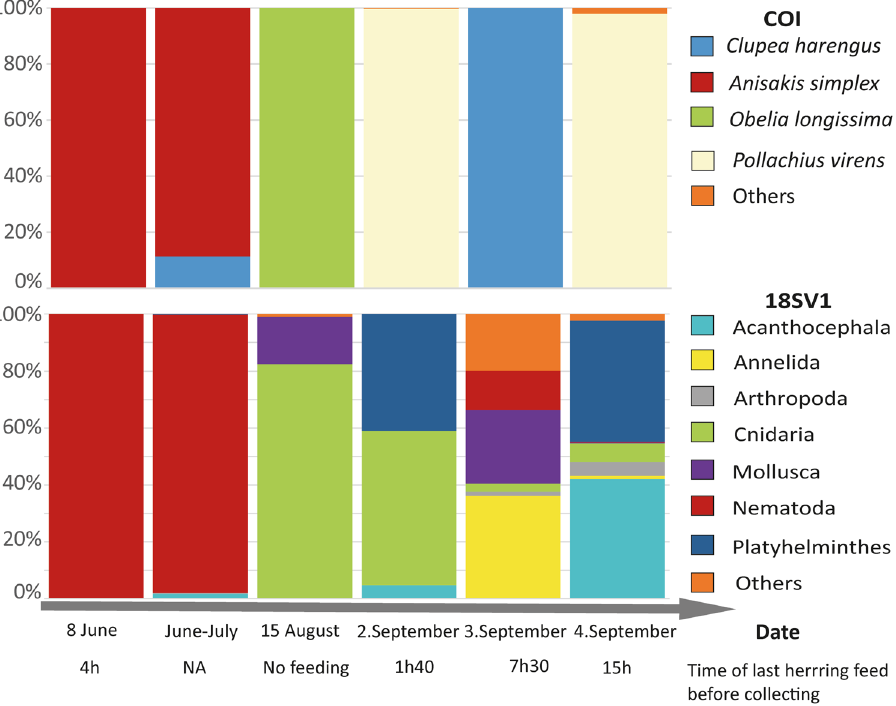
Figure 2. Relative proportions, generated separately for each gene region for each sample, of taxa encountered from COI (top) and 18S (bottom) metabarcodes, excluding all non-metazoan and beluga clusters. Time since last feeding is also detailed in Table